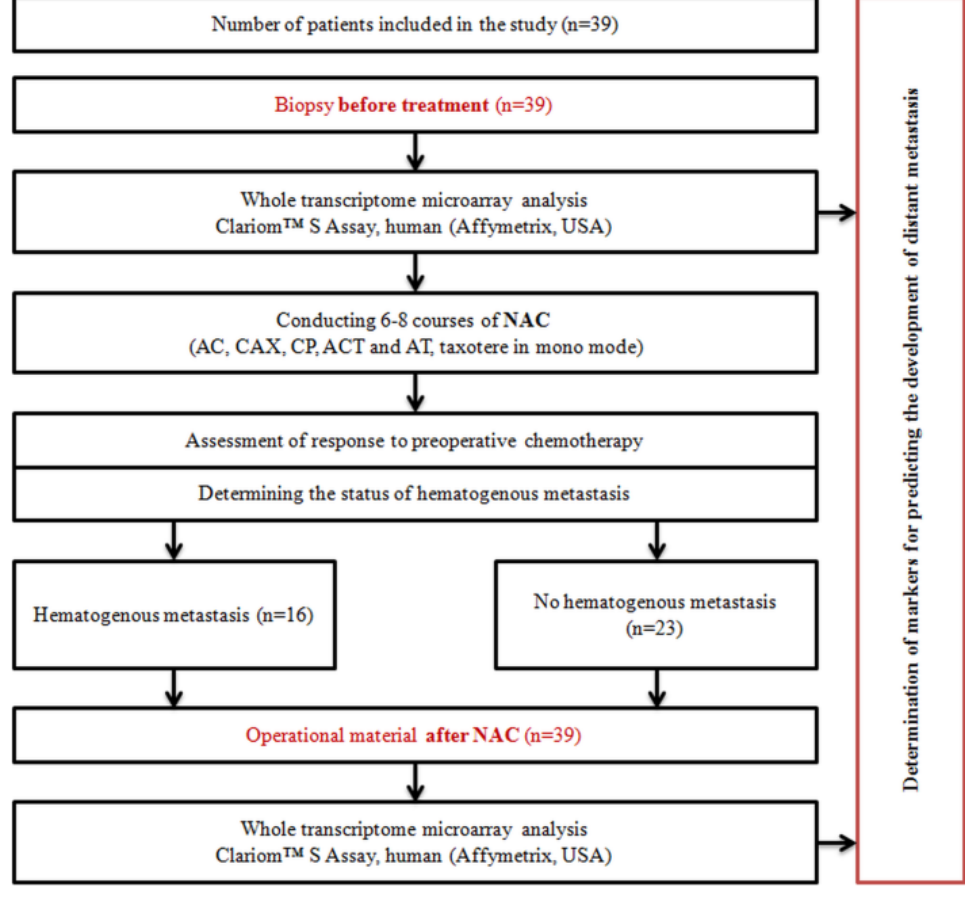
Figure 6. Study design.